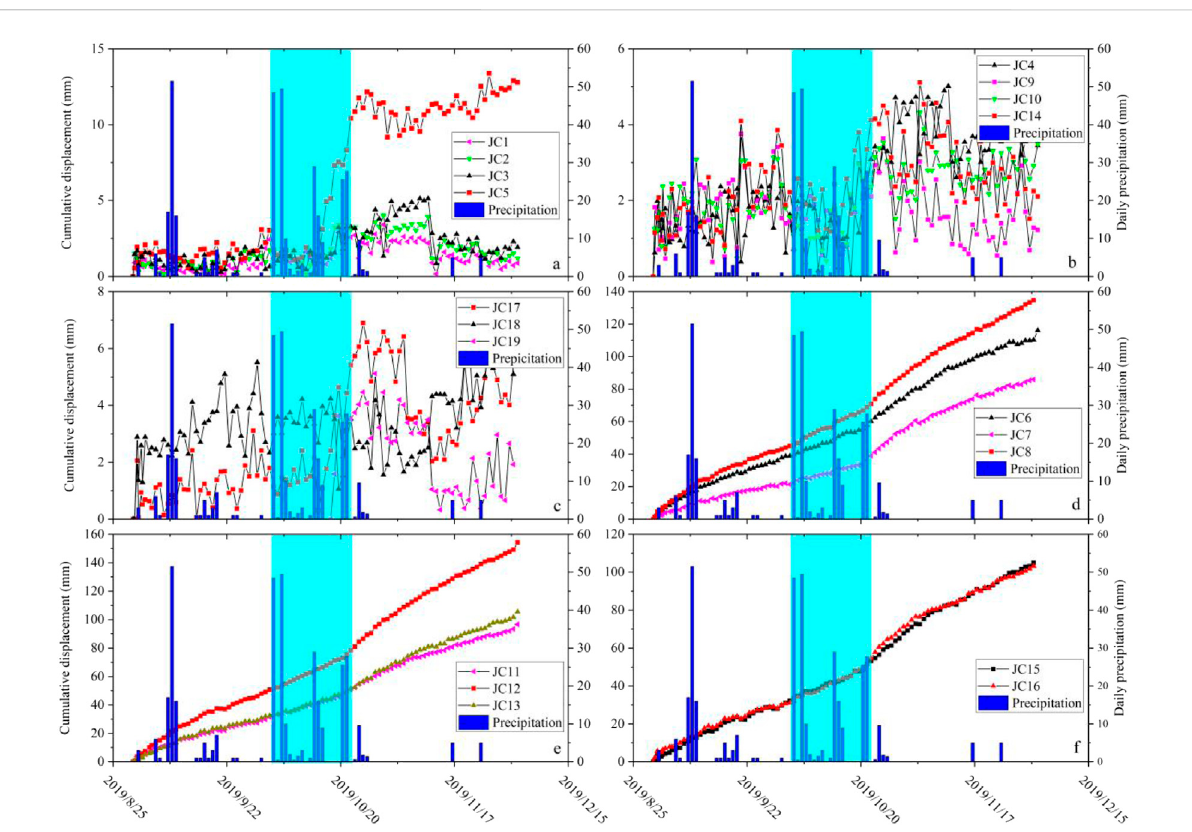
FIGURE 8 Monitoring results of the cumulative displacement and daily precipitation from August 30 to 2 December 2019. (A – C) are boundary control points; (D) is located at the open excavation zone in the leading part of the landslide; (E) is located along Ring Road; and (F) has been installed at the rear part of the landslide. The cyan section corresponds to the period from October 4 to 22, 2019, during which a continuous heavy rainfall event occurred, with a total precipitation of 228